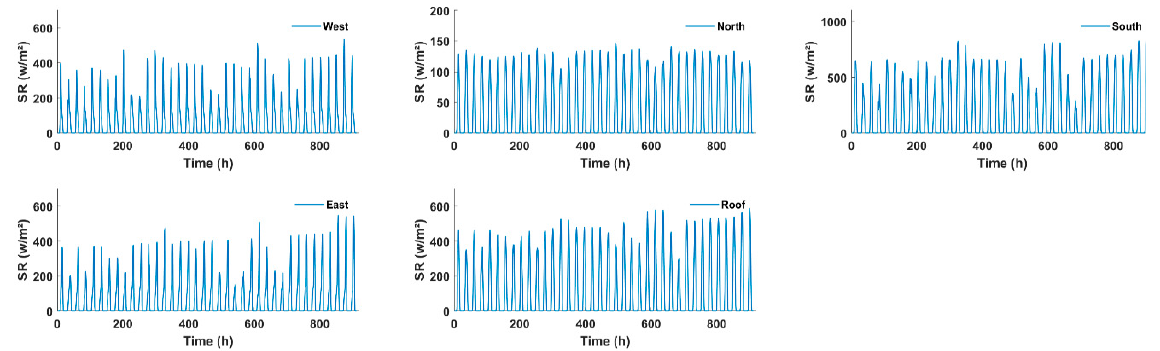
Figure 3. Outdoor temperature evolution for the considered period (38 days) in Sala Al Jadida, Morocco.